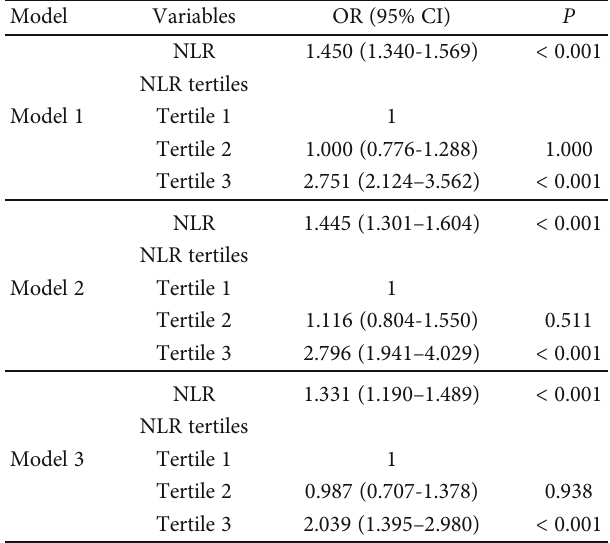
Abbreviations as in Table 1. Model 1: unadjusted. Model 2: adjusted for age, heart rate, respiratory rate, weight, TP, ALB, CREA, and TBIL. Model 3: adjusted for age, heart rate, respiratory rate, weight, TP, ALB, CREA, TBIL, PCT, and hsCRP.